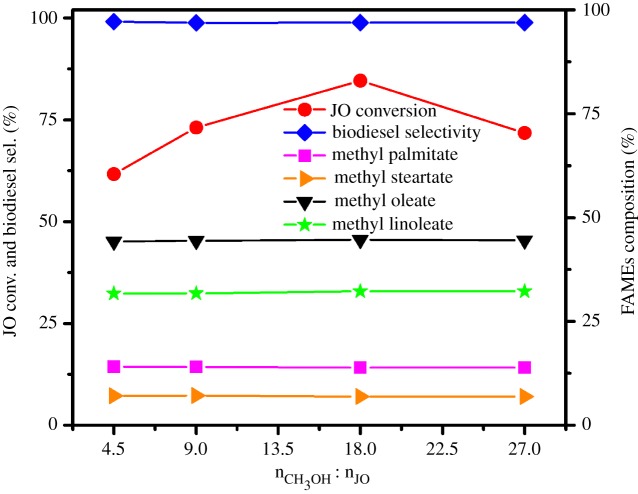
Effect of the nCH3OH : nJO on transesterification of JO. Reaction conditions: JO 3.0 g, methanol, petroleum ether 1.0 g, 1.5SO42−/TiO2 catalyst 0.12 g, 393 K, 24 h, stirring rate 600 r.p.m.